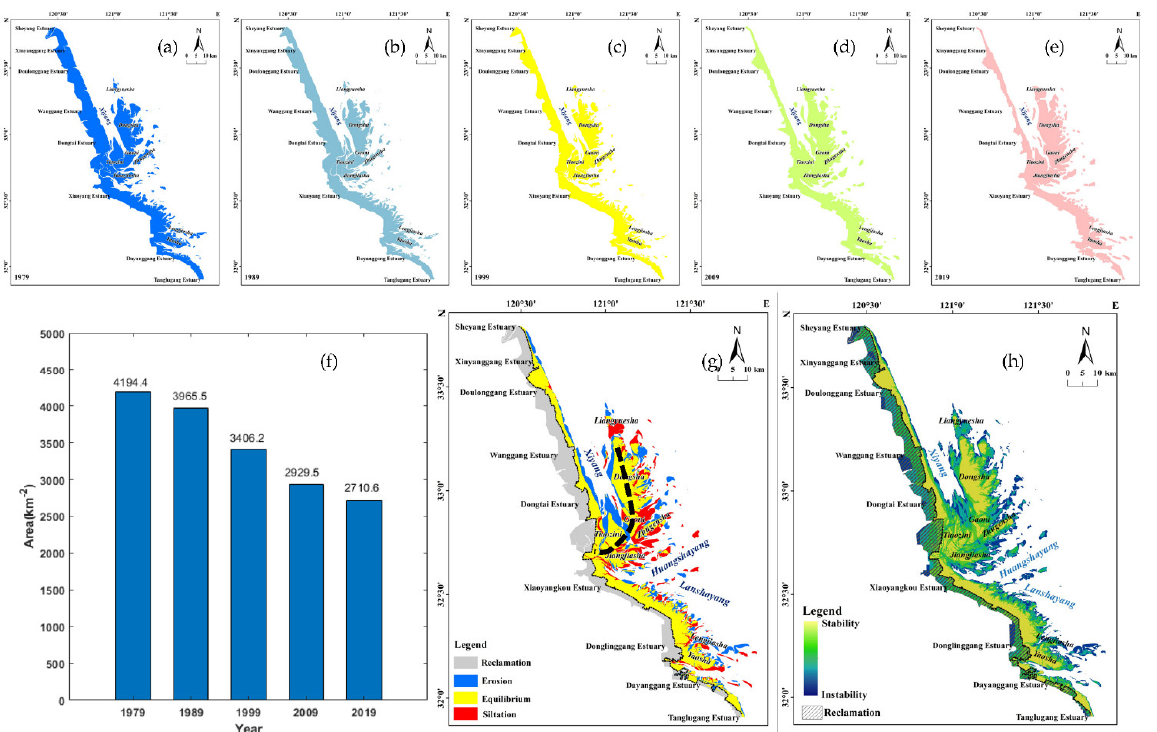
Figure 7. ( a – e ) Distribution map of exposed tidal flats from 1979–2019; ( f ) area comparison between five periods; ( g ) overlay map between 1979 and 2019; ( h ) stability spatial distribution map based on overlay analysis of five polygon layers ( a – e ).